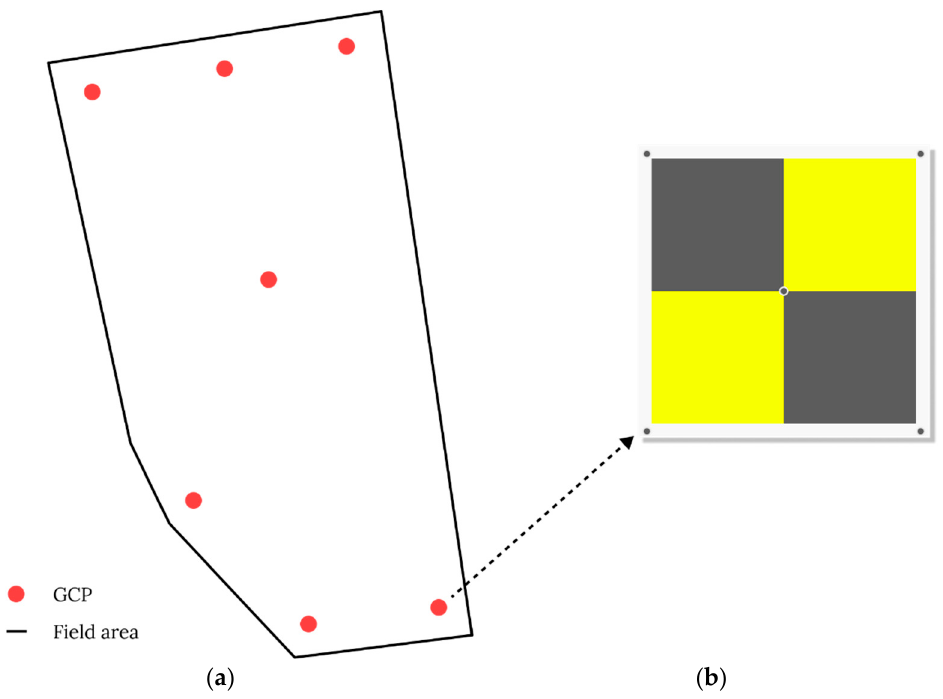
Figure 4. Examples of ( a ) GCP distribution for aerial surveys conducted on a pear orchard [61] and ( b ) a standard 60 × 60 cm GCP used for aerial survey [62].